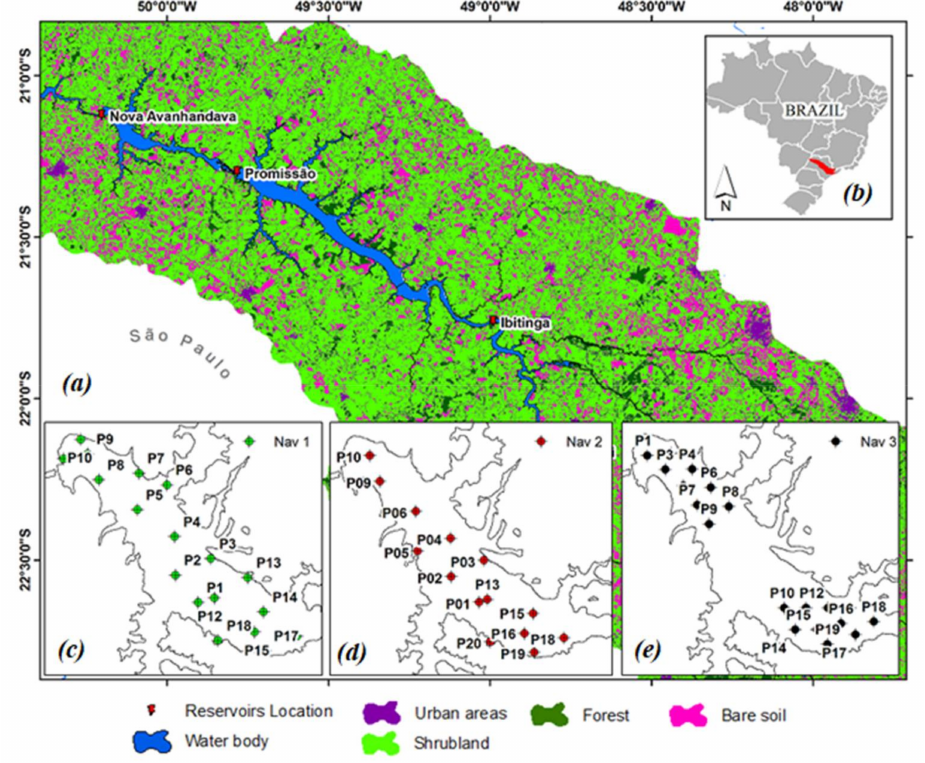
Figure 1. Map of the study area emphasizing ( a ) the land cover of the Tiet ê River basin and the cascade system (from upstream to downstream: Barra Bonita, Bariri, Ibitinga, Promiss ã o, Nova Avanhandava, and Tr ê s Irm ã os); ( b ) Tiet ê River basin placed in S ã o Paulo State and ( c ) the distribution of the sampling locations for Nav 1; ( d ) Nav 2, and ( e ) Nav